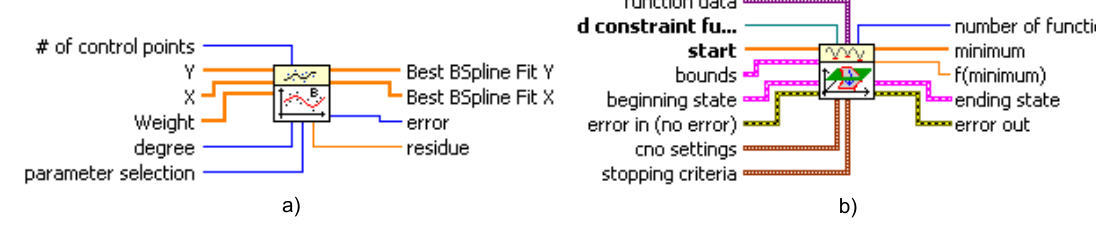
Figure 18. The two main Virtual Instruments (VIs) used to solve the optimization problem; ( a ) the B-Spline Fit VI and ( b ) the Constrained Nonlinear Optimization